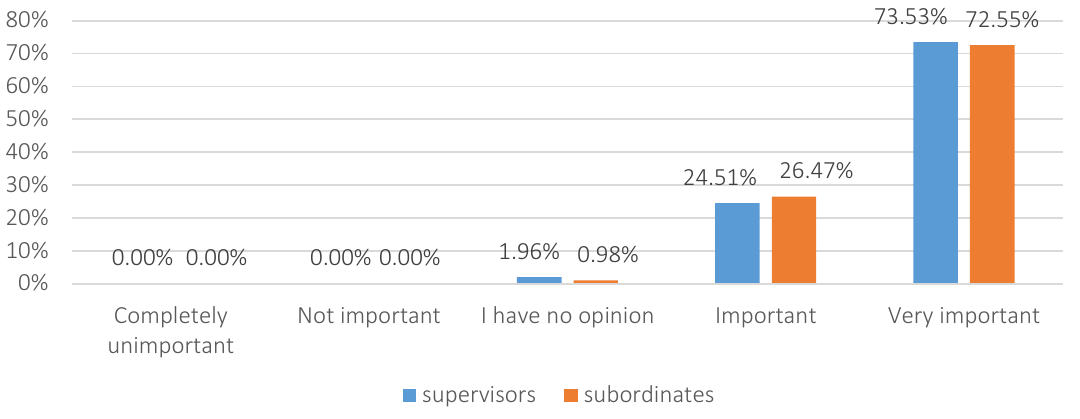
Figure 4. Telling the truth – a summary for the groups of supervisors and subordinates